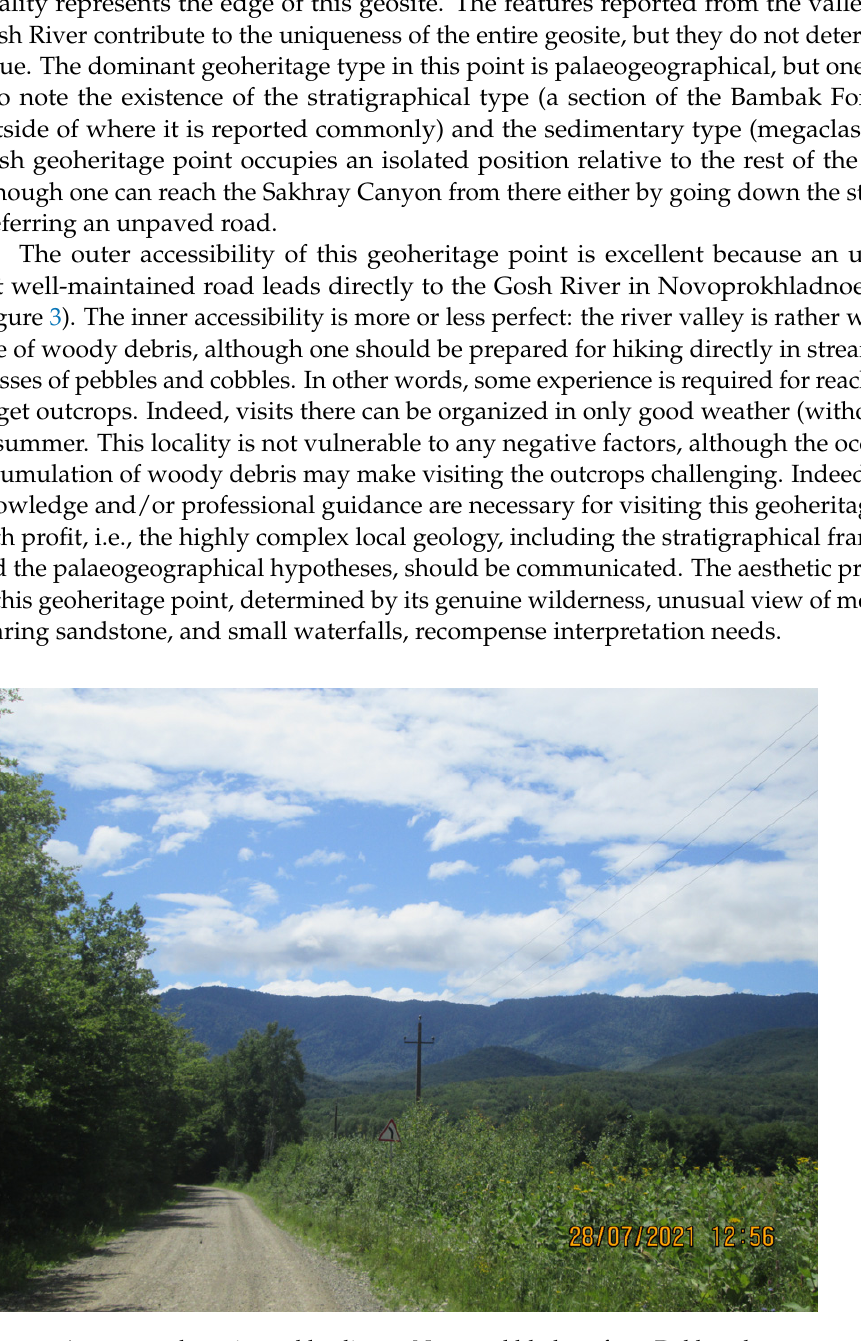
Figure 3. An unpaved scenic road leading to Novoprokhladnoe from Dakhovskaya.